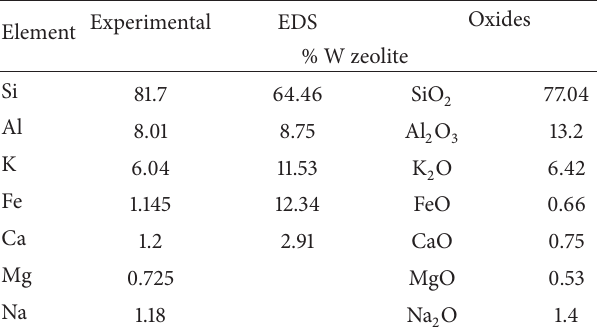
Table 1: Chemical composition of natural zeolite. Element Experimental EDS